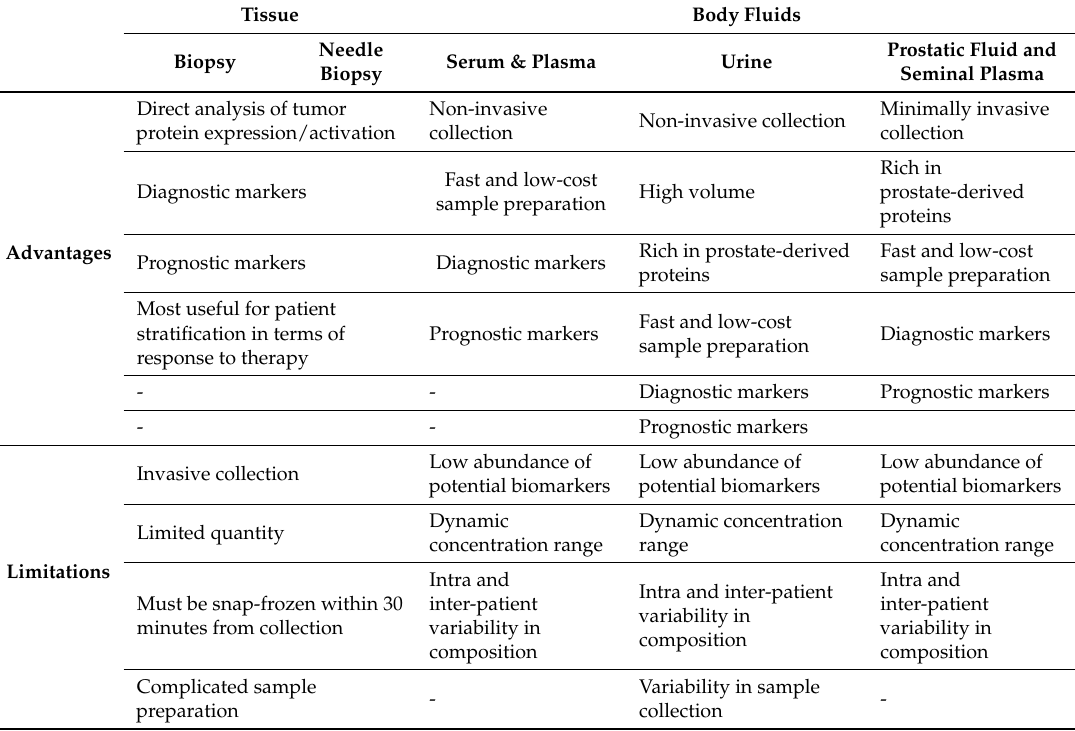
Table 4. Considerations for Sample Selection for Biomarker Discovery 1